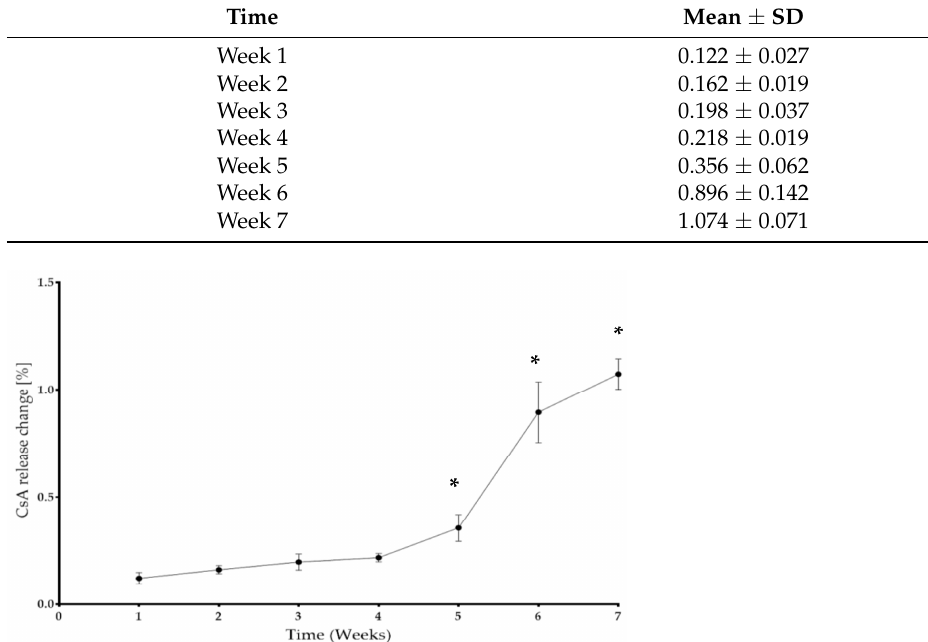
Table 3. The average percentage of degraded CSA implants through time.